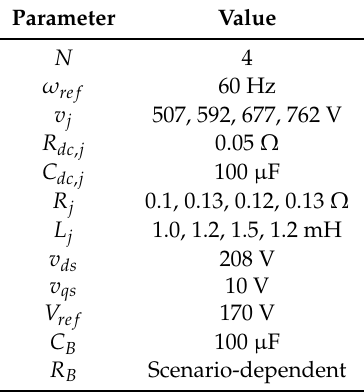
Table 4. Simulation